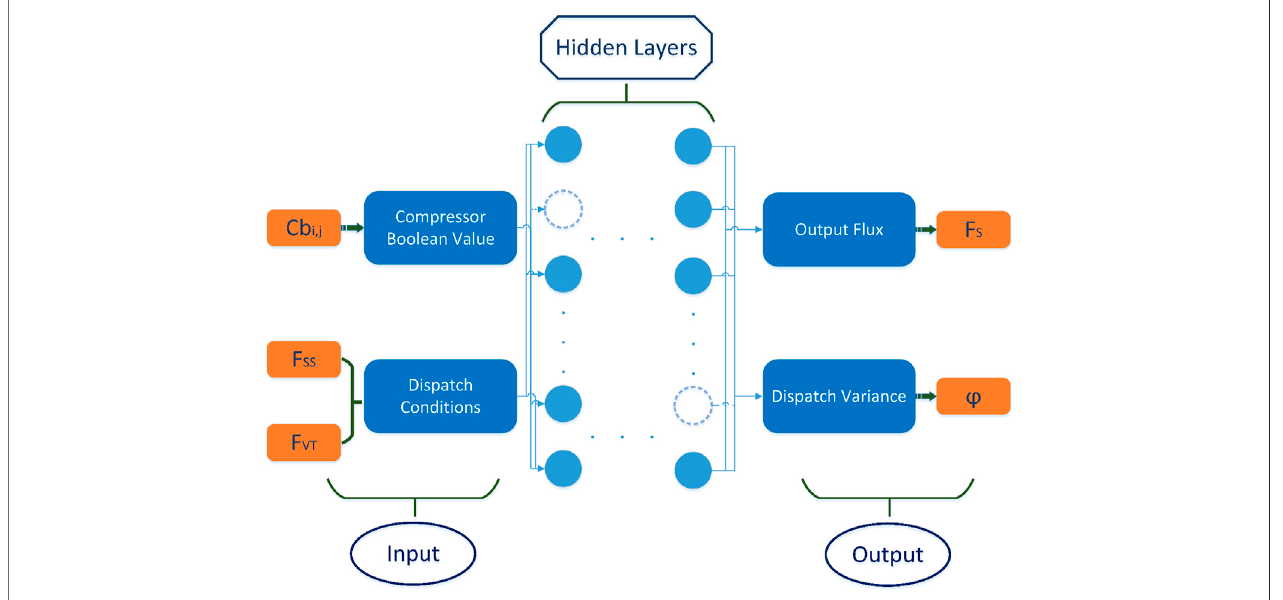
FIGURE 7 | Compressor boolean neural network